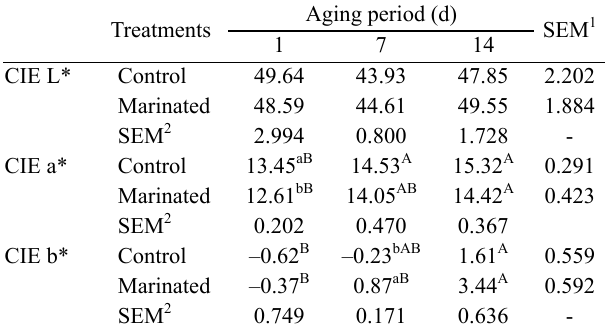
Table 5. Effect of aging and marination on lipid oxidation of duck breast meat